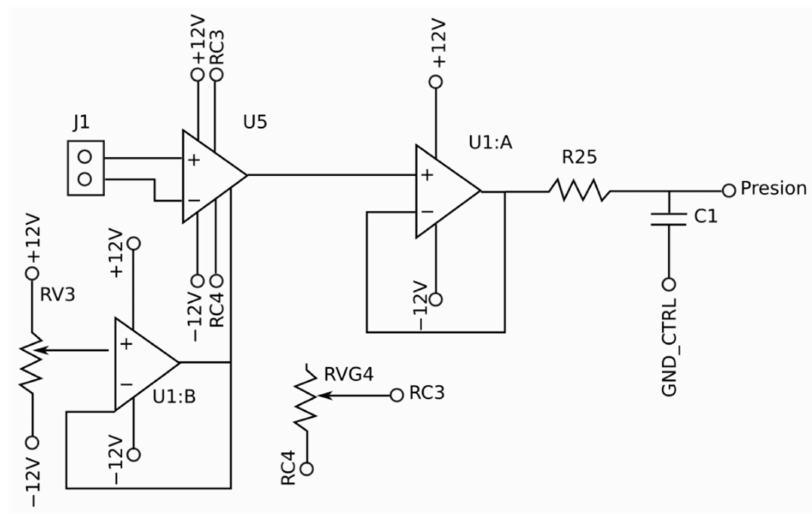
Figure 6. Oxygen sensor wiring diagram.